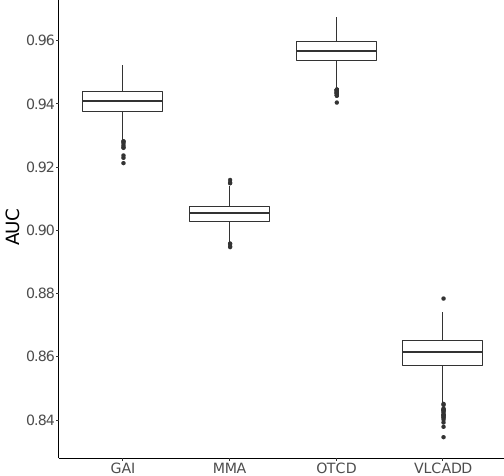
Figure 2. Assessing the performance of RF using cross validation. A 10-fold cross validation (1000 repeats) of the RF model was performed for each disorder to classify each screen positive as either a true or false positive. Only RF scores from testing samples were used to plot the ROC curve and to calculate the AUC. The small variation in AUC values without extreme outlier cases for each disorder demonstrates the overall stability of our RF model.